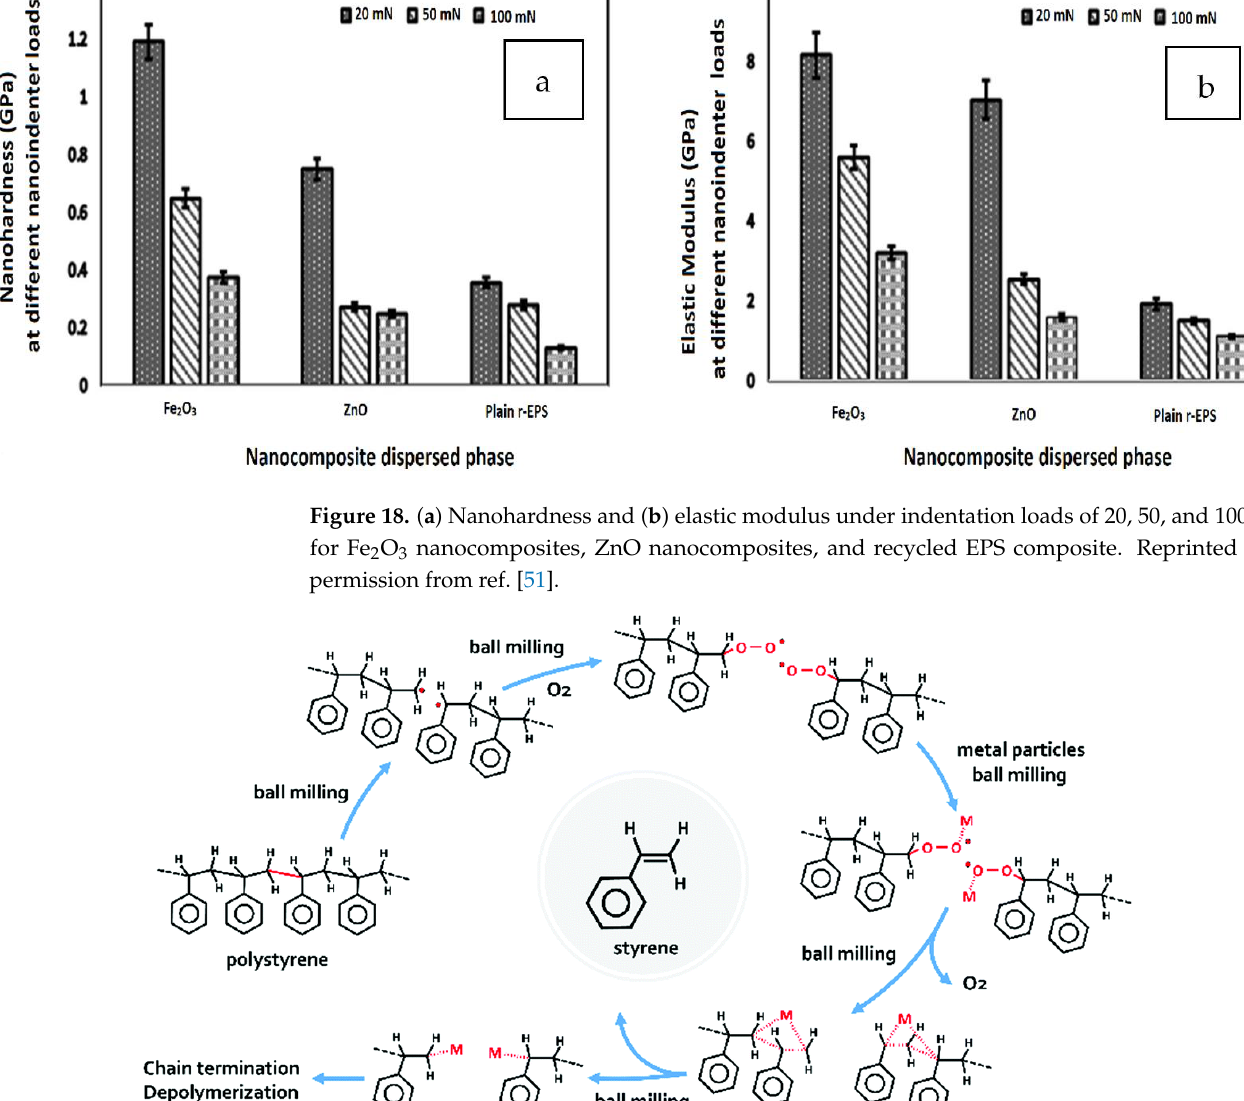
Figure 19. Proposed mechanism of polystyrene depolymerization in salt and oxidized copper scrubber. Reprinted with permission from ref.